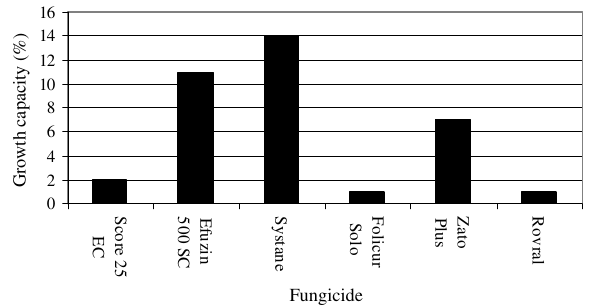
Figure 2. Percent growth capacity of Monilinia laxa for 6 fungicides (approved in integrated production) admended on PDA plates at 1 × dosage recommended by the manufacturer (LSD